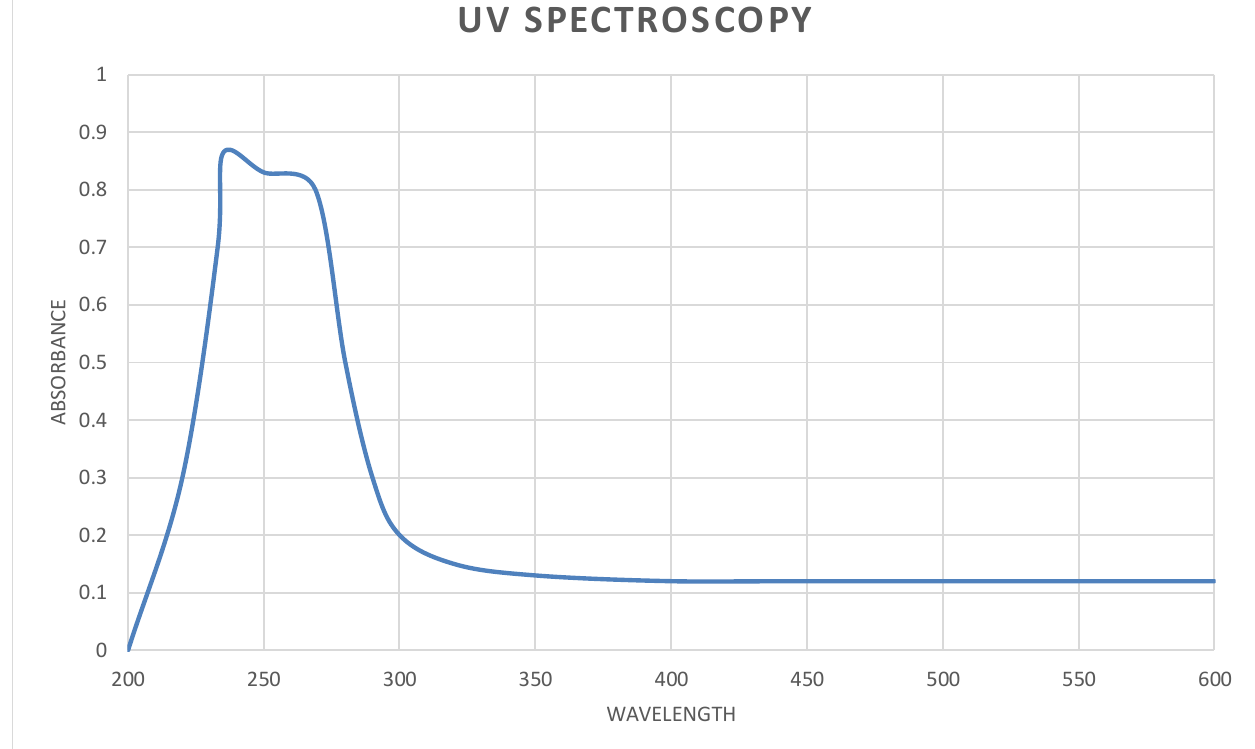
Figure 10: UV absorbance spectrum of PHA extracted from A. lwoffii